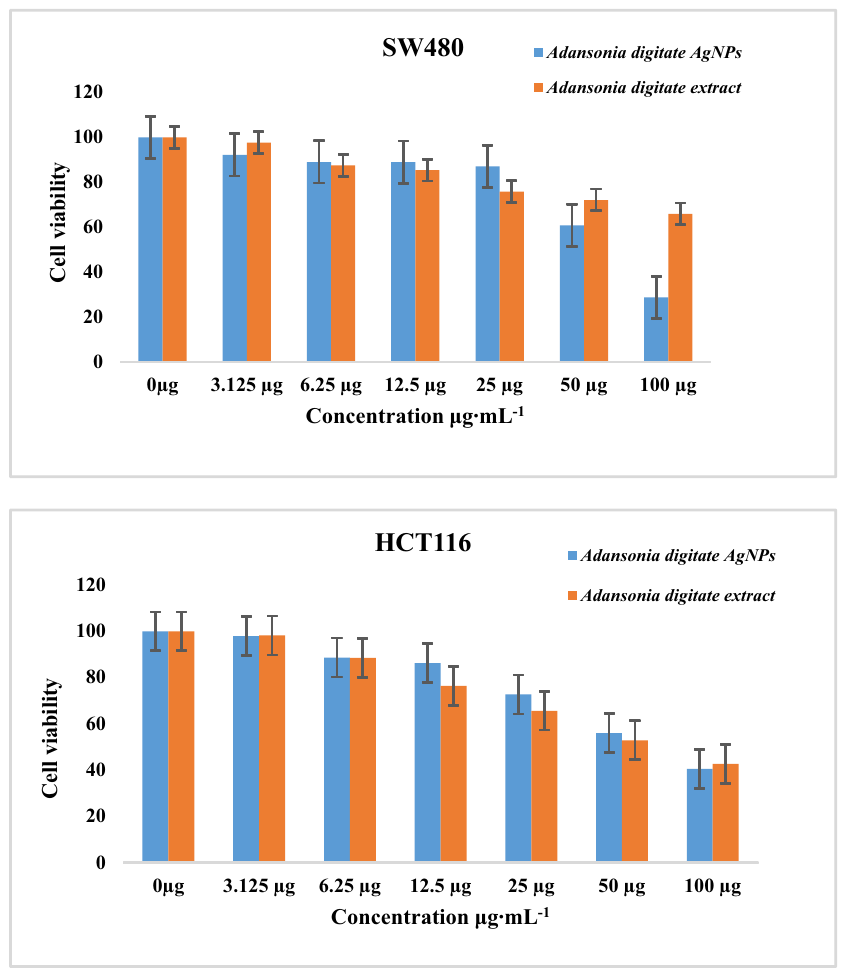
Figure 7: Cytotoxicity of A. digitata extract and green - synthesized A. digitata AgNPs on human colon cancer cell lines SW480 and HTC116 following 24 h